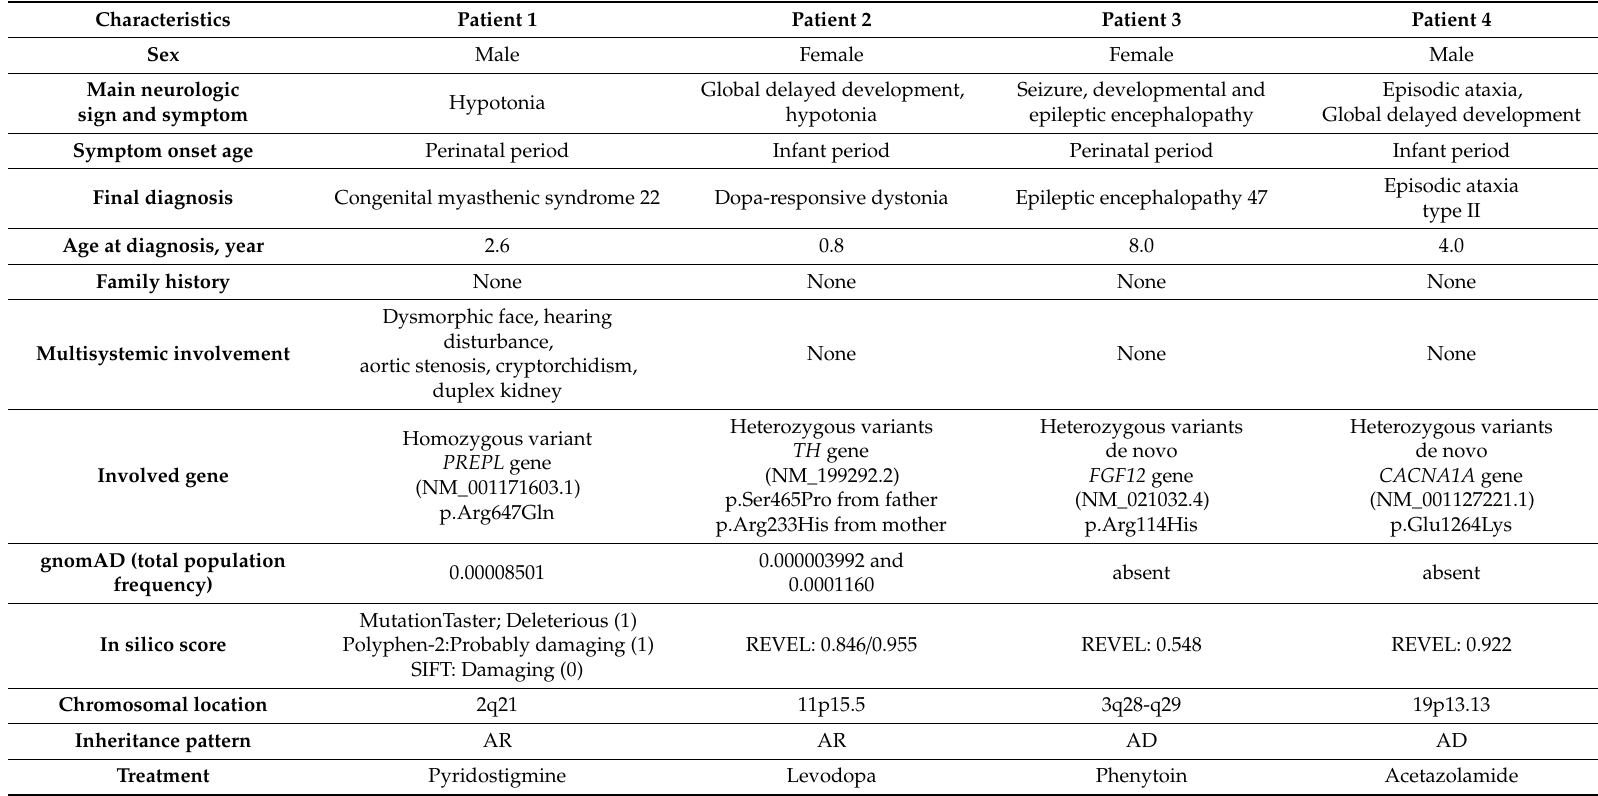
Table 1. Clinical characteristics of patients with treatable rare neurogenetic